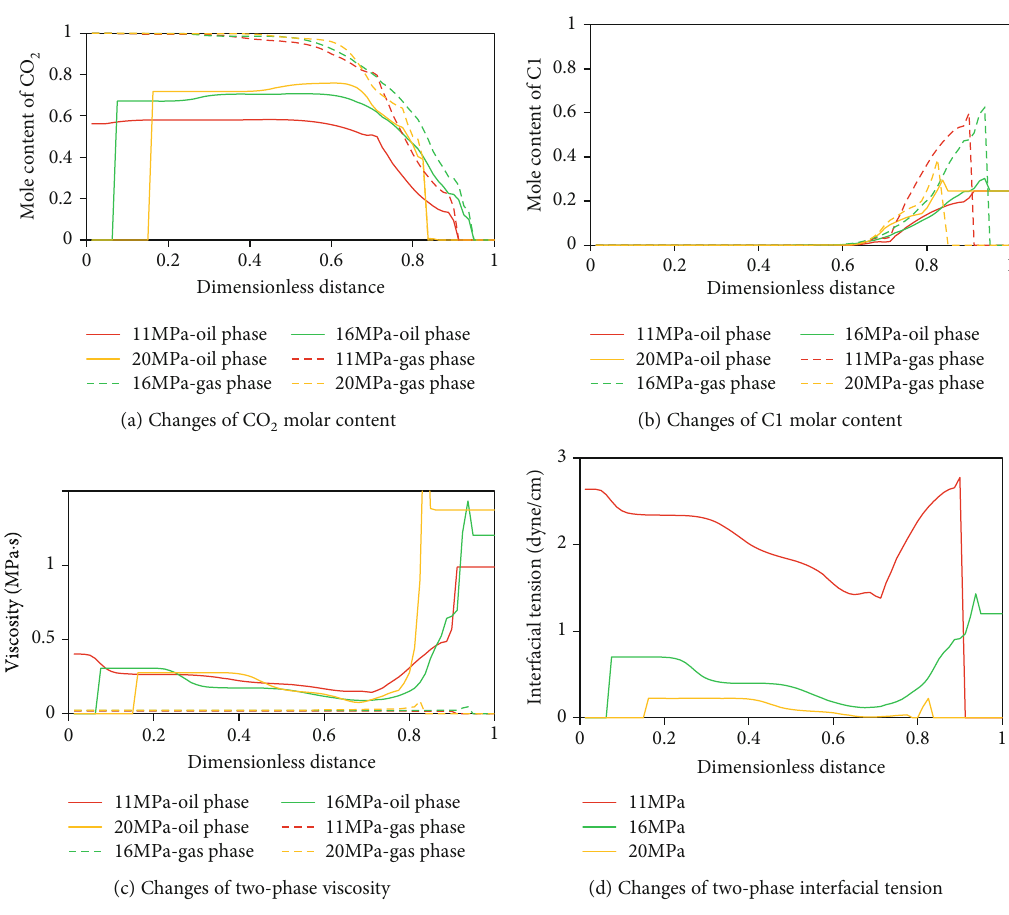
Figure 7: Changes of two-phase fl uid properties at di ff erent pressures.